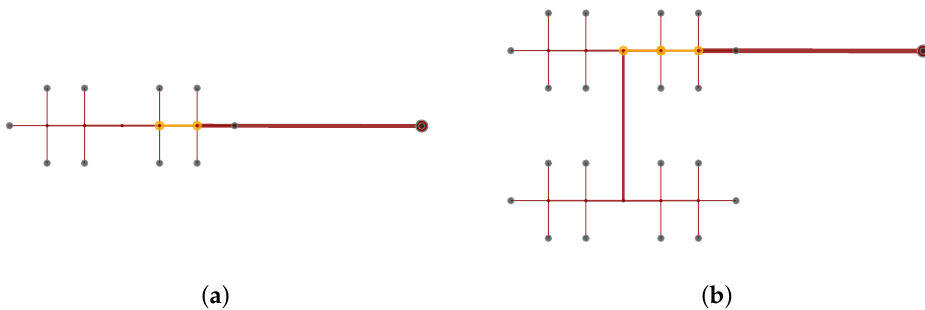
Figure 12. Bottlenecks (highlighted in orange) in the separated district heating networks of the generic use-case. ( a ) Separated network scenario 1; ( b ) Separated network scenario